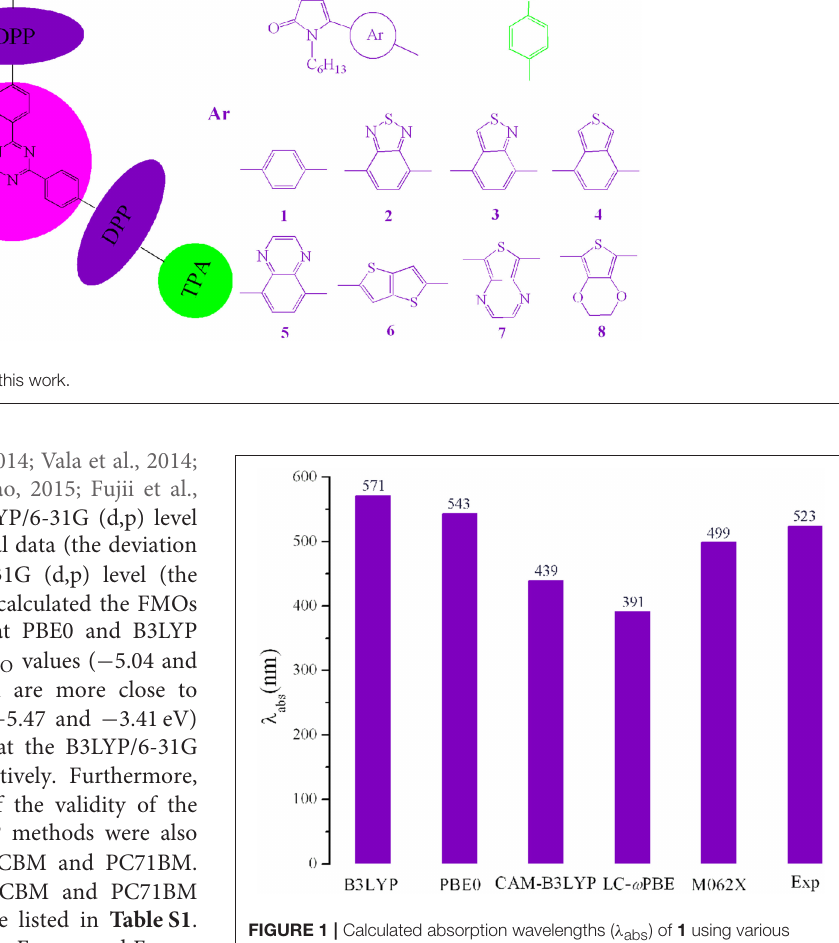
FIGURE 1 | Calculated absorption wavelengths ( λ abs ) of 1 using various functionals, together with the experimental